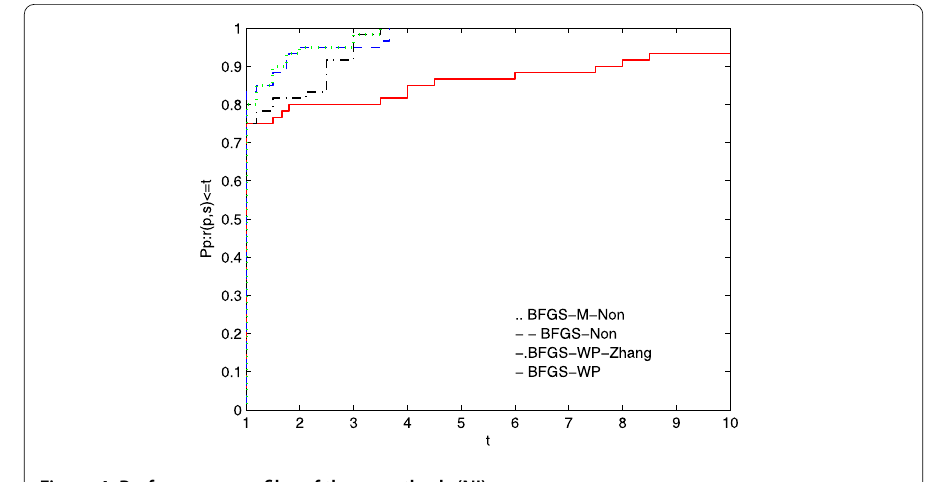
Figure 4 Performance profiles of these methods (NI).